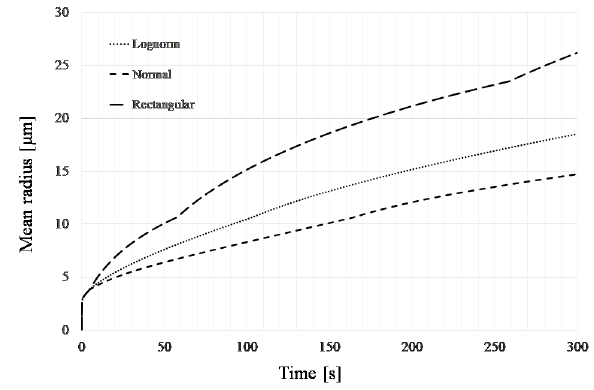
Figure 2: Mean radius over time for three different grain size distri- bution